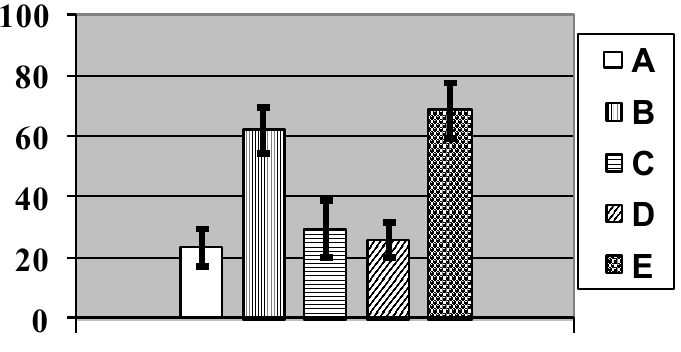
Figure 9. Number of cells without a nucleolus per 100 Golgi cells in nucleus caudatus of rats exposed (A) to water (Control); (B) to water suspension of copper oxide nanoparticles; (C) to the same against the background of bioprotective complex (BPC) administrations; (D) to the BPC only; (E) to water suspension of Cu/Cu O submicron particles (Average 2 values with 95% CI). Differences are statistically significant between (B) and (A), (E) and (A), and (C) and (B) ( p < 0.05 by Student’s t